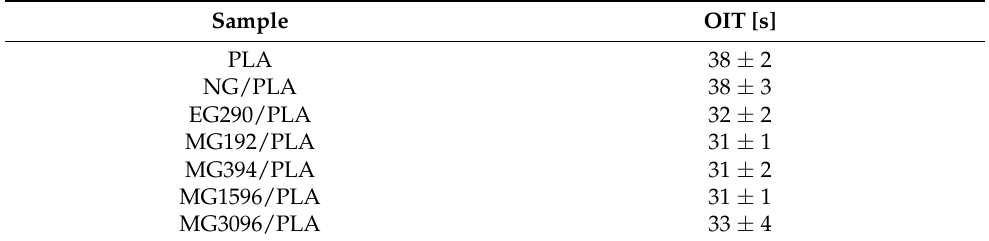
Table 4. OIT values with standard